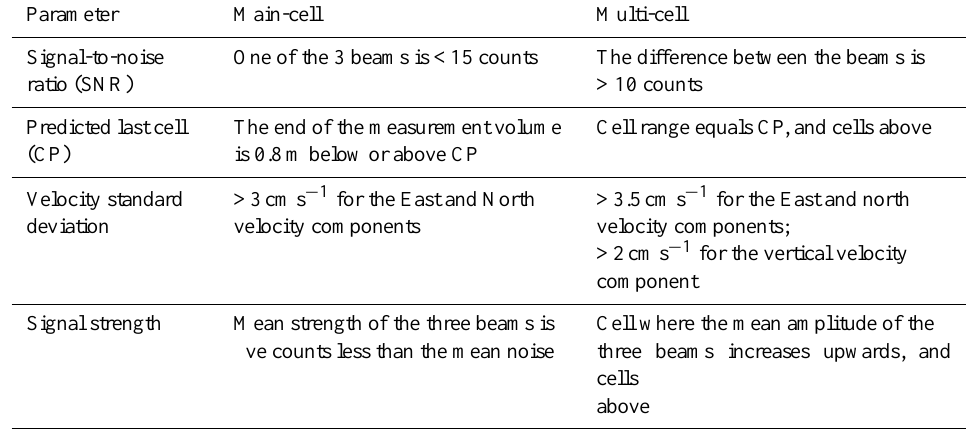
Table 4. Quality check conditions for invalidation of the ADP main-cell and multi-cell velocity